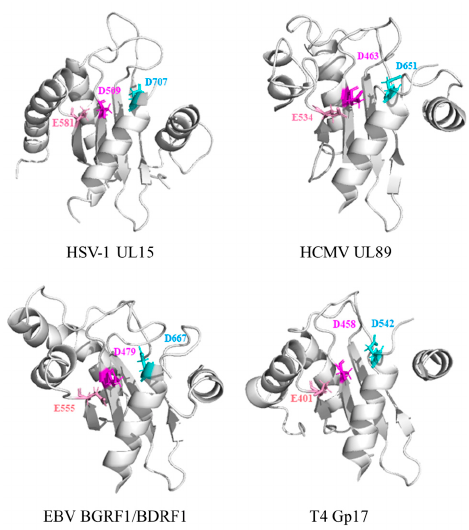
Figure 5. Comparison of the terminase large subunit active site region with those of HSV-1 pUL15, HCMV pUL89C, EBV BGRF1/BDRF1, and T4 Gp17, showing conserved features and structural variations. The conservative residues of the active site were marked. The protein structure models were produced using the I-TASSER